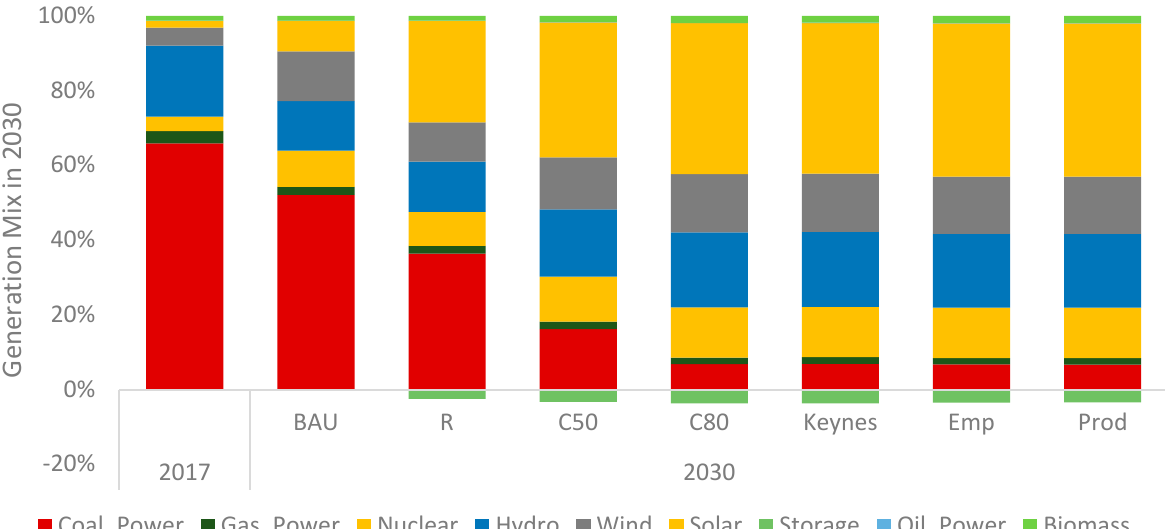
Figure 3. Generation mix of the power sector in the base year (2017) and in 2030.